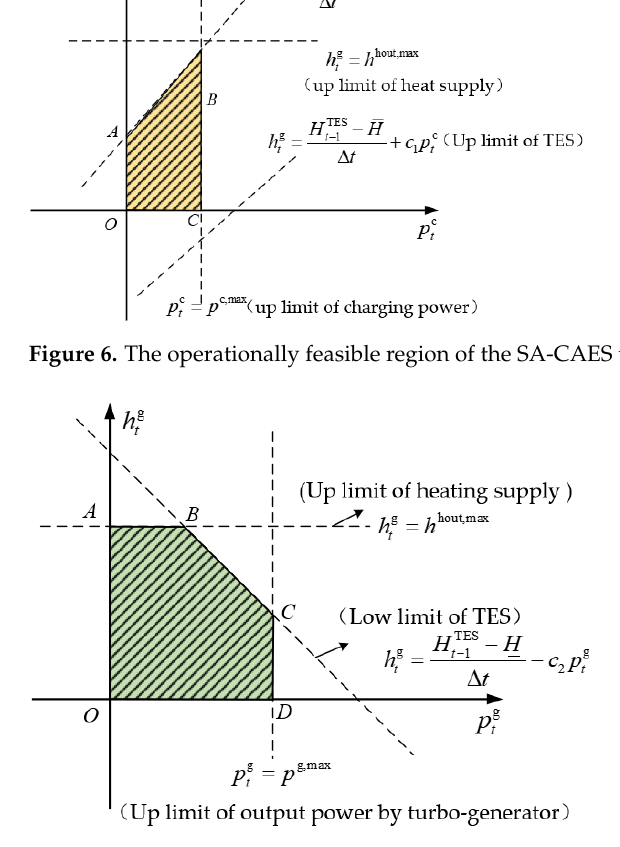
means of the integration of the solar field and the TES unit. Therefore, it can inject flexible the temperature at the intended level during extreme